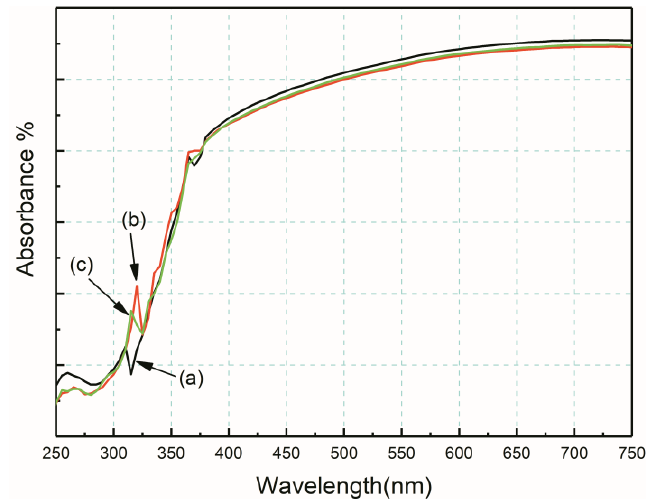
Figure 4. UV-Vis reflectance spectra of TiO 2 coatings: ( a ) TiO 2 -12-0, ( b ) TiO 2 -12-30, and ( c ) TiO 2 -20-30.